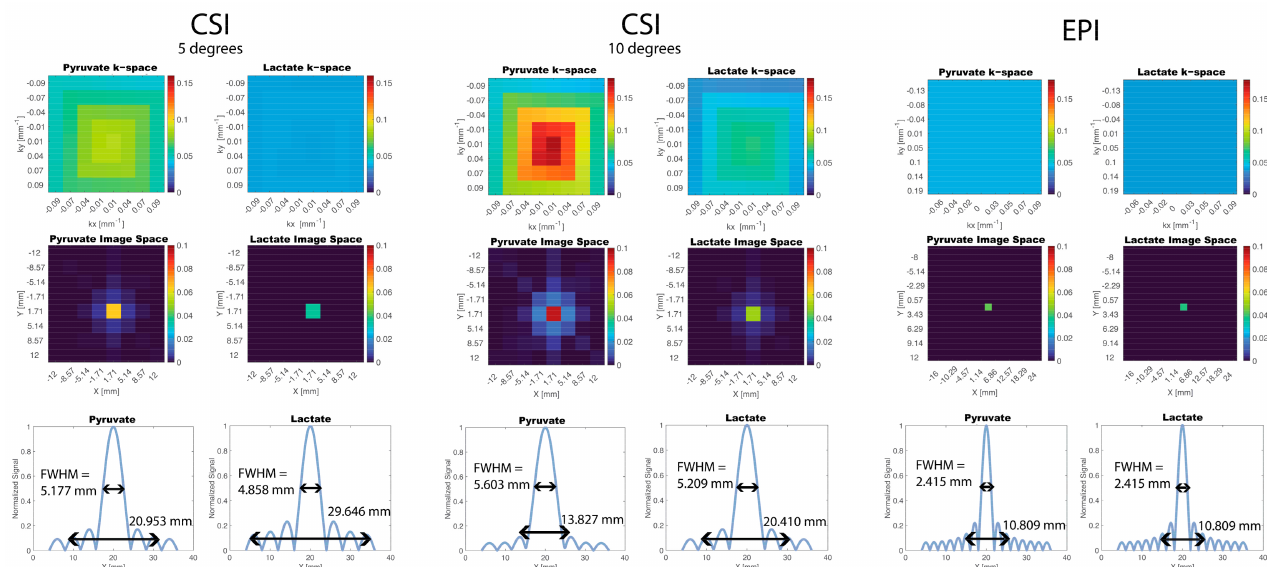
Figure 2. Simulation of PSF for CSI and EPI Acquisition. Magnetization decay was modelled across k-space using a pharmacokinetic model. The CSI PSFs resulted in signal blurring in image space whereas the EPI PSF resulted in a delta function. The CSI PSFs for two different flip angles are shown: 5 degrees and 10